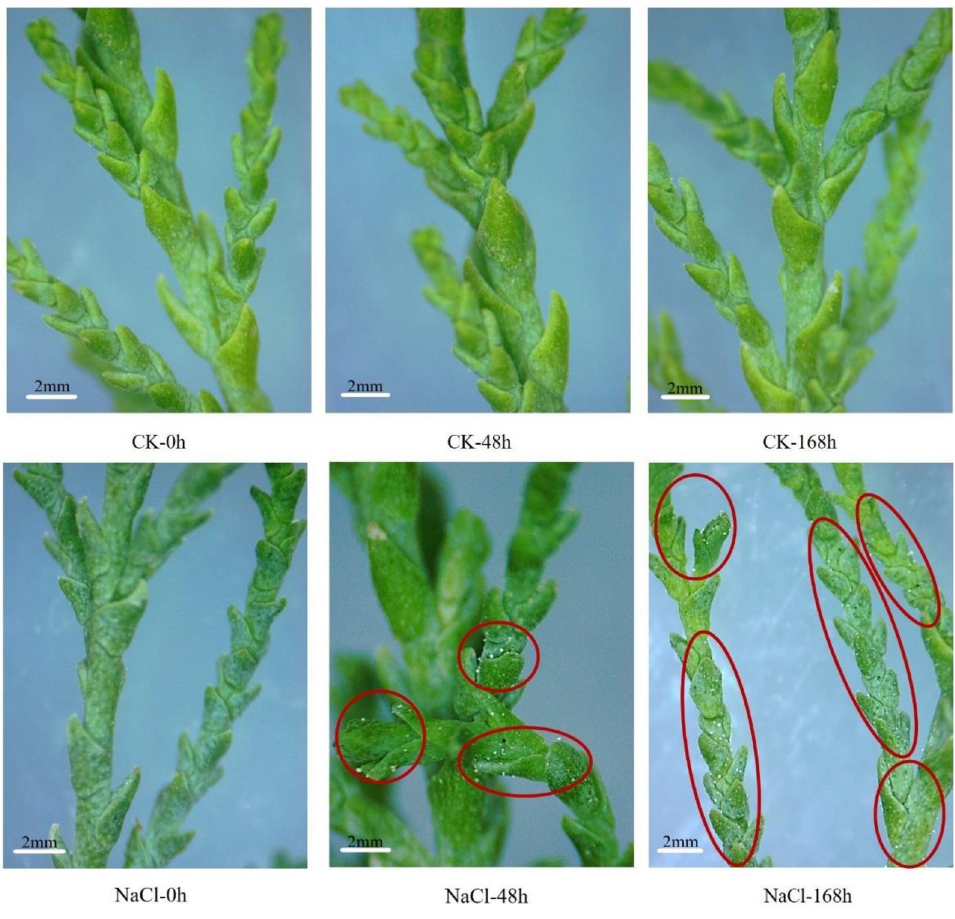
Fig 1. Salt secretion from T . ramosissima leaves under NaCl stress. [Leaf salt secretion are checked in the leaves of T . ramosissima at 0h, 48h and 168h under 200mM NaCl treatment (The red labels indicate the salt secretion products)].